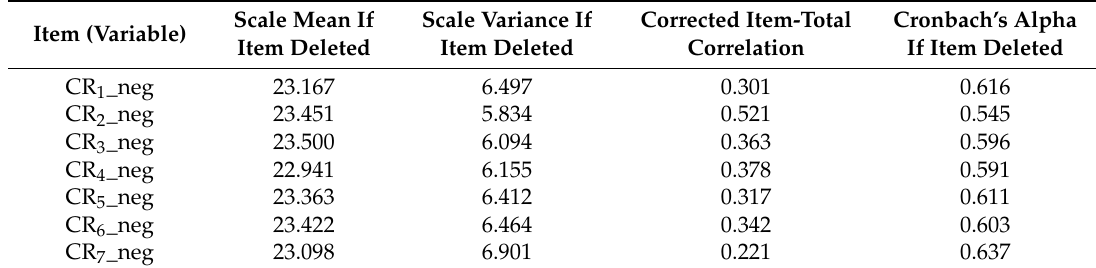
Table 3. Negative items overall